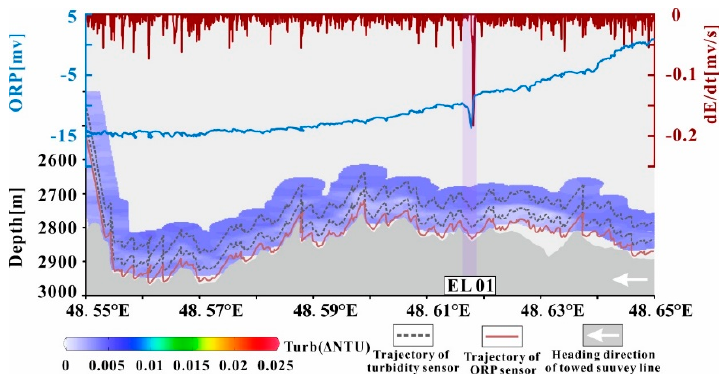
Figure 4. Hydrothermal plume distribution along line EL01. The seafloor relief, Δ NTU, ORP and negative dE/dt are shown. The top blue line is ORP and the top brown line is dE/dt. The purple band indicates a suspected hydrothermal anomaly site.